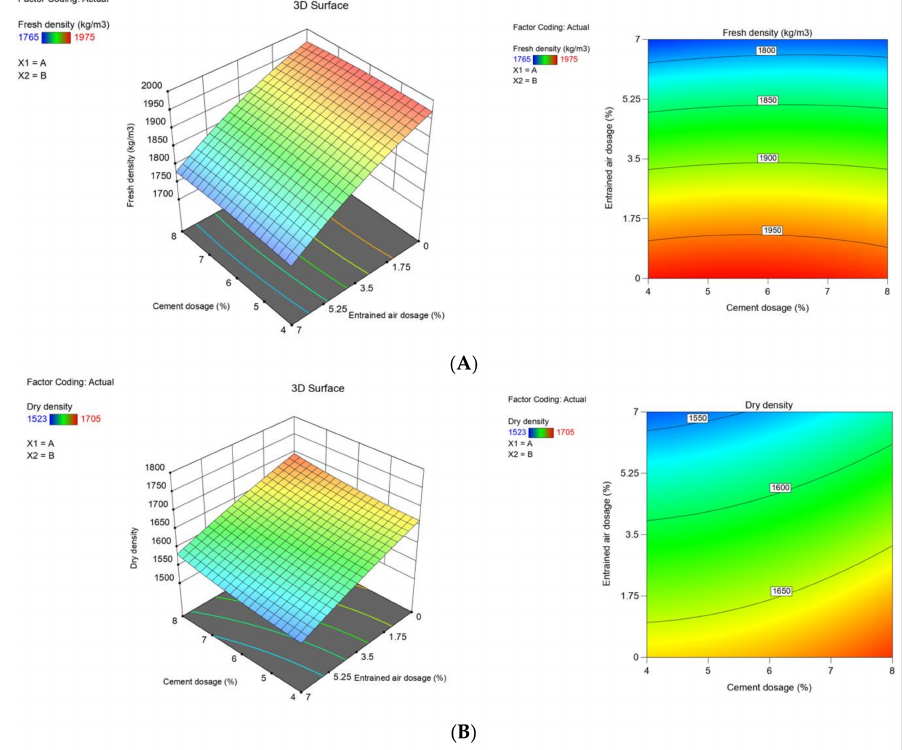
Figure 15. Response surfaces and contour plots for ( A ) fresh density and ( B ) dry